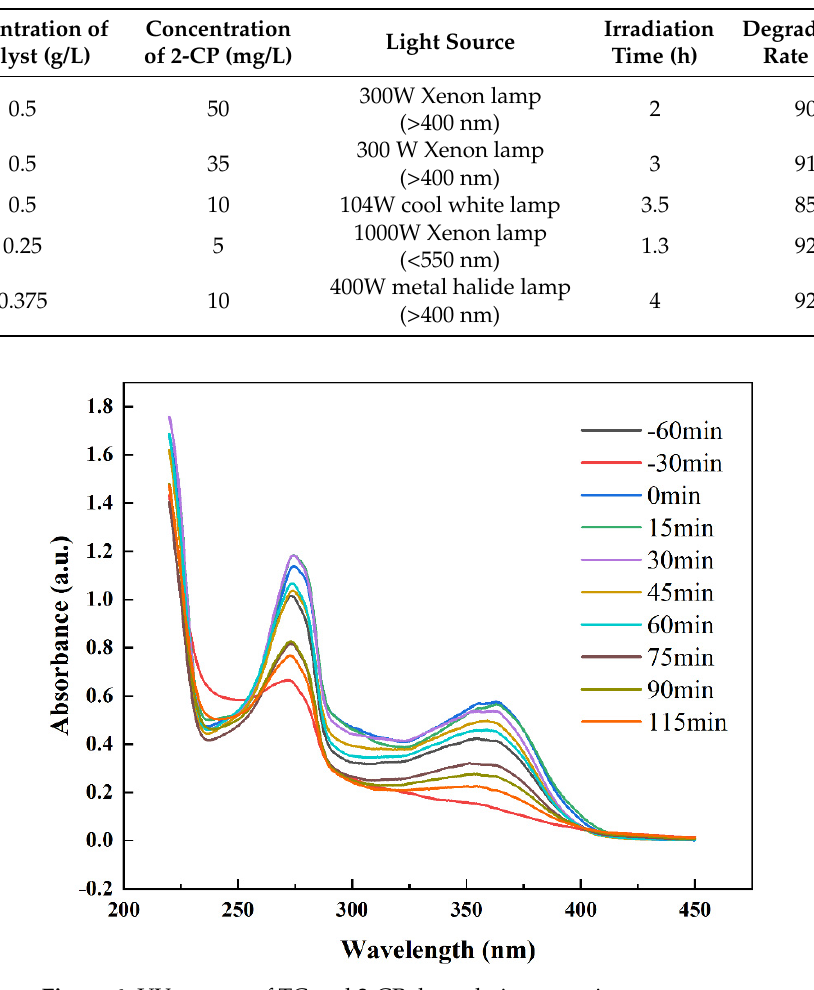
Figure 6. UV-spectra of TC and 2-CP degradation over time on stream.